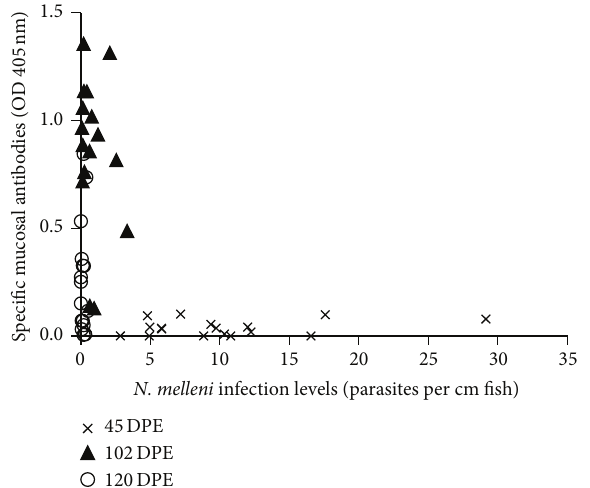
Figure 4: Relationship of specific mucosal antibodies to infection levels in continuously exposed tilapia as determined by nonpara- metric multivariate analysis. Antibody levels of mucus samples diluted 1:3 in PBS (optical density, 405 nm) and corresponding infection levels (parasites/cm fish) for individuals at each time point are indicated by × = 45 DPE, 󳵳 = 102 DPE, and I = 120 DPE. Mucosal antibodies and infection levels showed significant negative correlation (Kendall’s 𝜏 = − 0.3006, 𝑟 = 0.4289 , 𝑃 < 0.01